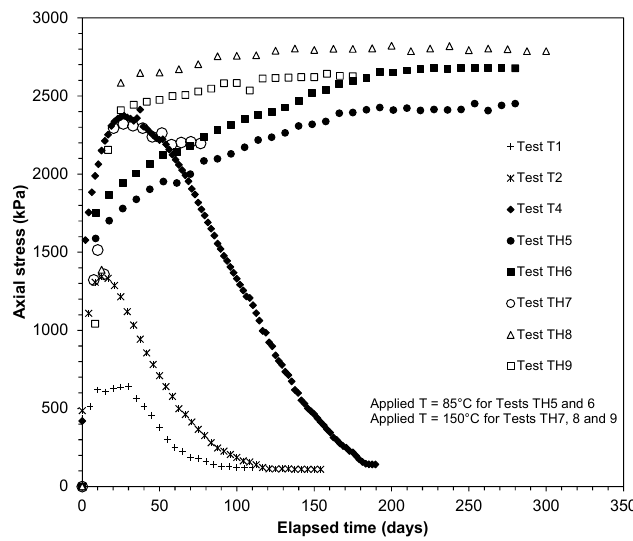
Figure 14. Development of axial stress due to applied thermal and thermo-hydraulic gradients.